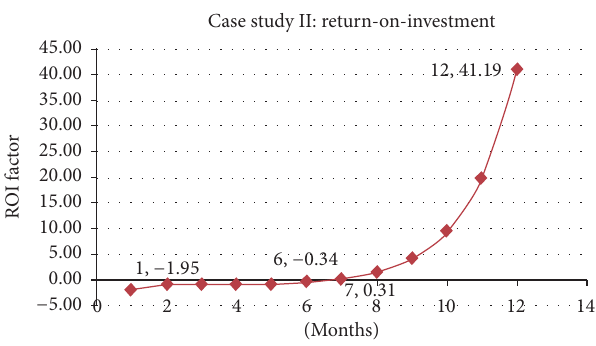
Figure 5: Graphical representation of ROI for Table 14.